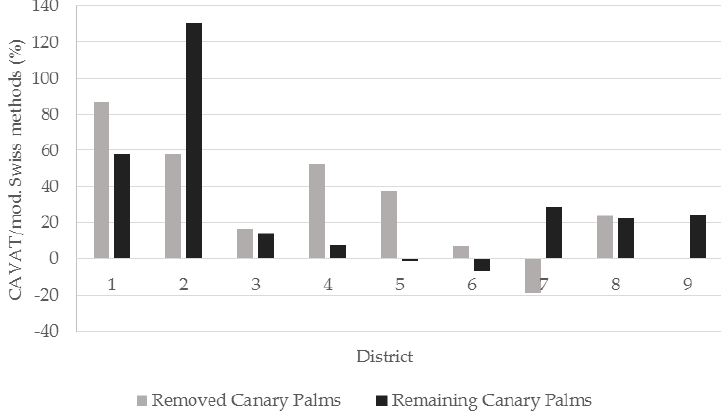
Figure 4. Percentage differences of the ornamental value, by the Monte Carlo analysis, between the modified Swiss and the CAVAT methods, per district.